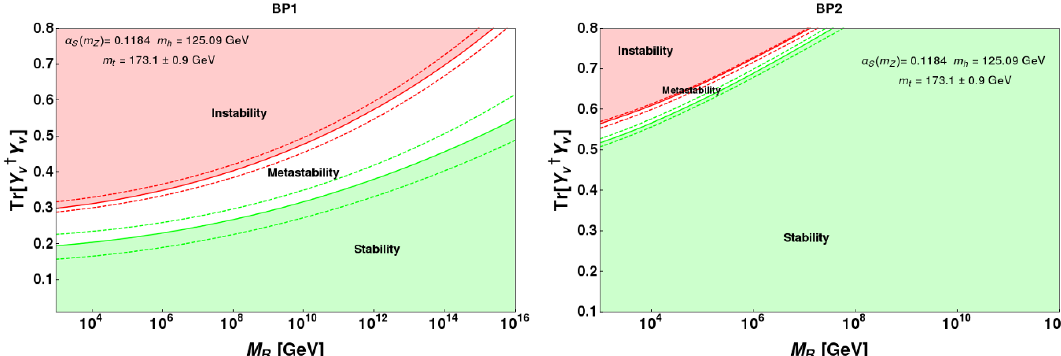
Y (cid:23) ] plane for the (cid:23)